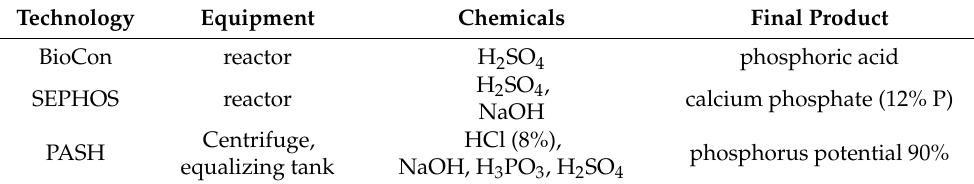
PASH equalizing tank NaOH, H 3 PO 3 , H 2 SO 4